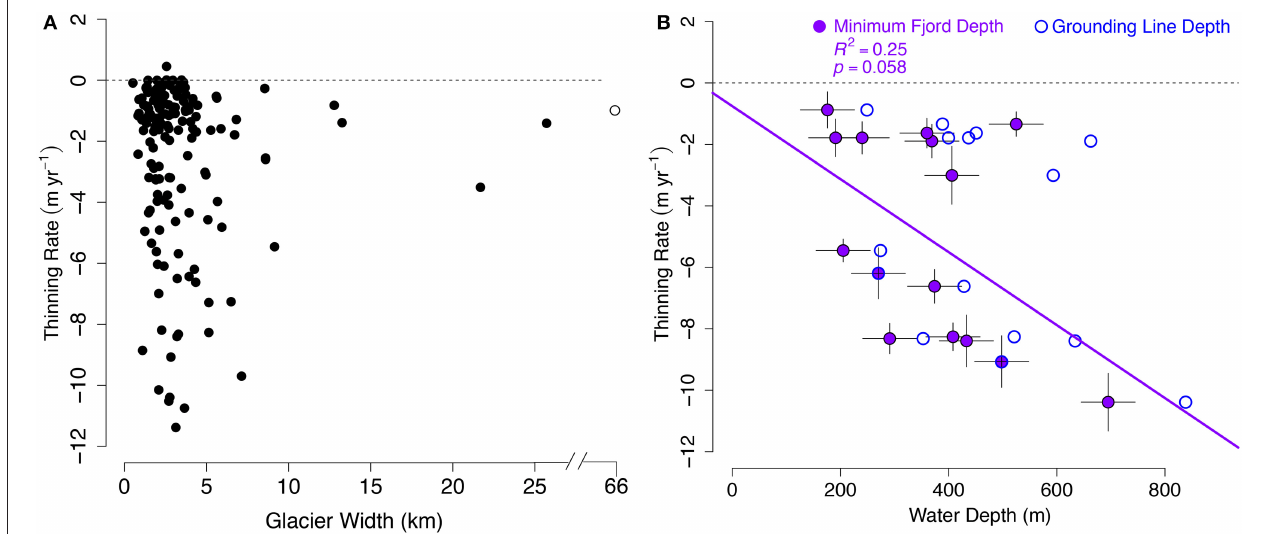
FIGURE 8 | (A) Scatterplot of glacier width vs. maximum dynamic thinning rate ( m yr − 1 ) for the total glacier set. Humboldt glacier has a width of over 66 km (outside the bounds of the plot) and is indicated as an open circle. (B) OLS regression for Northwest glaciers, as in Figure 5 , instead for the minimum seafloor depths (m) along trough centerlines from the head of the fjord to the outer shelf using NASA OMG swath bathymetry and airborne gravity data. Grounding line depths (used in original analysis) are in open blue circles, minimum fjord depths for those glaciers are in solid